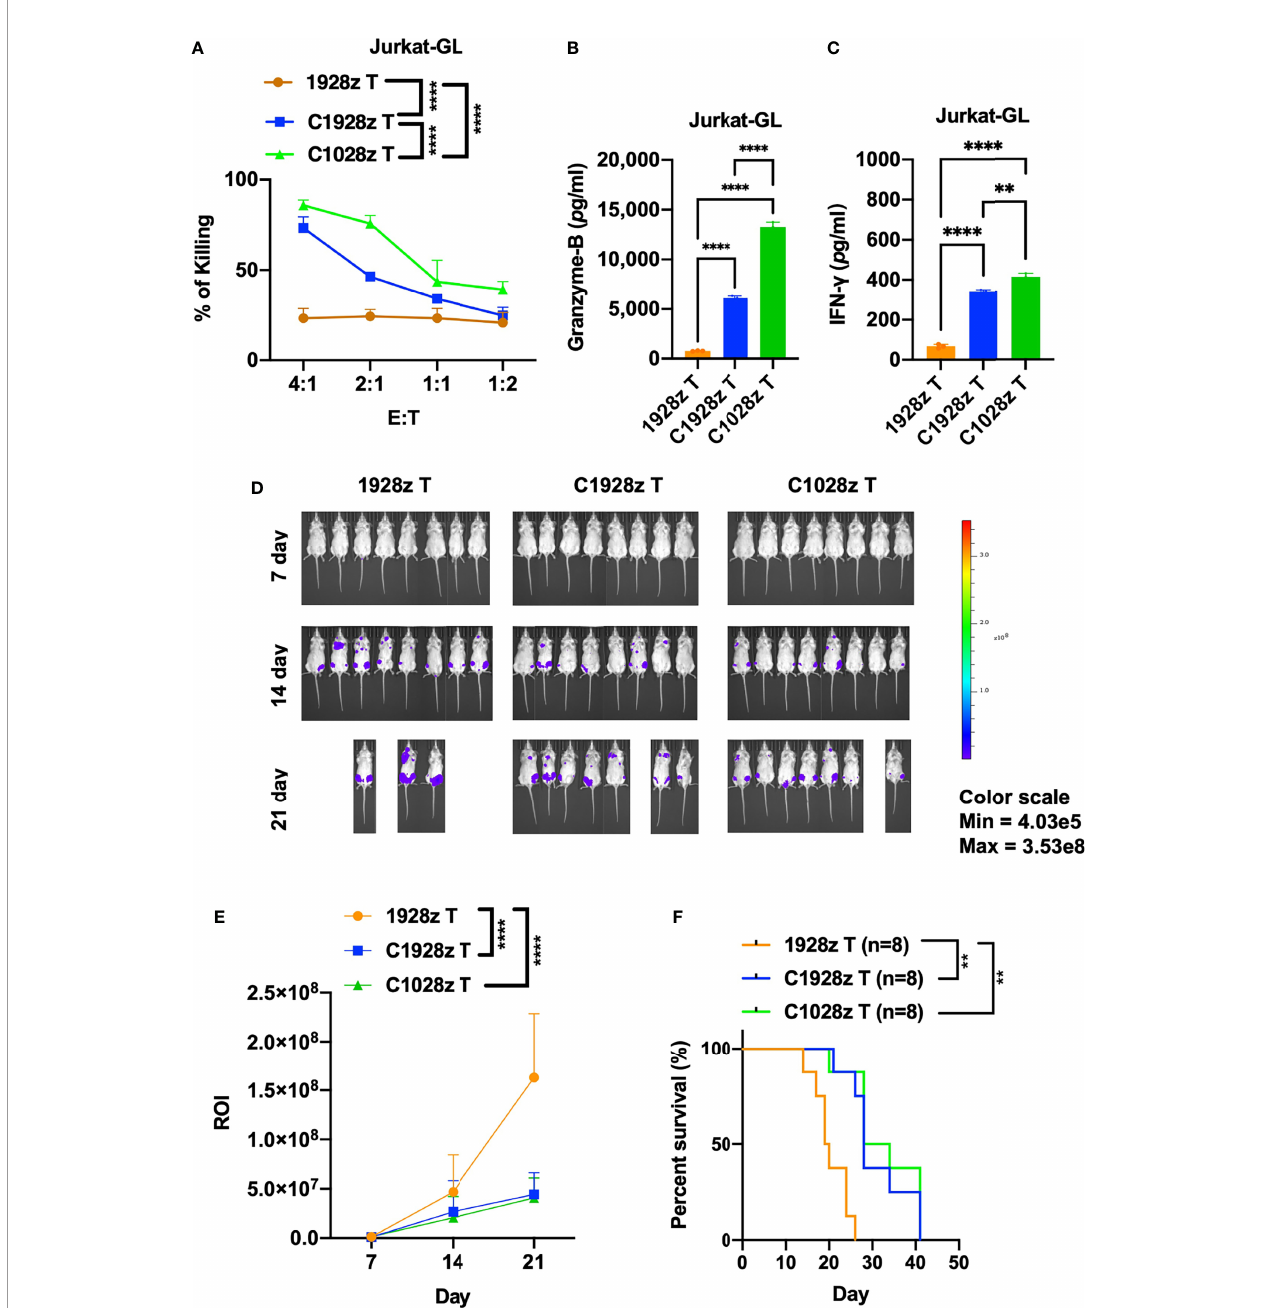
FIGURE 5 | Anti-CCR8 CAR T cells exhibited antitumor ef fi cacy against CCR8-expressing T-ALL cells. (A) The percentages of Jurkat cells whose lysis was induced by 1928z, C1928z and C1028z T cells; (B, C) 1928z, C1928z and C1028z T cells were incubated with Jurkat cells at a 4:1 effector (E) : target (T) ratio in 96-well round-bottom plates for 24 hours at 37°C. Supernatants were then harvested and analyzed with a multiplex immunoassay to determine the concentrations of the indicated cytokines. The concentrations of Granzyme-B (B) and IFN- g (C) were measured by ELISA; (D, E) BLI of mice intravenously injected with Jurkat-GL cells and then treated with 1928z, C1928z or C1028z T cells. Brie fl y, NSI mice received an i.v. injection of 1 × 10 6 Jurkat-GL cells ( N = 8 mice/group). Representative results of one from two repeated experiment are shown (total mice/group = 12). After 2 days, 2 × 10 6 1928z, C1928z or C1028z T cells were injected through the tail vein, and BLI was conducted on Days 7, 14 and 21. (E) Statistical analysis of the ROI of BLI at each time point ( N = 8 mice/group); (F) Kaplan-Meier survival analysis of treatment with1928z, C1928z or C1028z T cells were shown ( N = 8 mice/group). (A, E) Data are shown as the mean ± SEM values; two-way ANOVA with Tukey ’ s multiple comparisons test; **P ≤ 0.01, ****P ≤ 0.0001; (B, C) Data are shown as the mean ± SEM values; one-way ANOVA with Tukey ’ s multiple comparisons test; **P ≤ 0.01, ****P ≤ 0.0001; (F) Statistical analysis for survival curves represents log-rank test, **P ≤